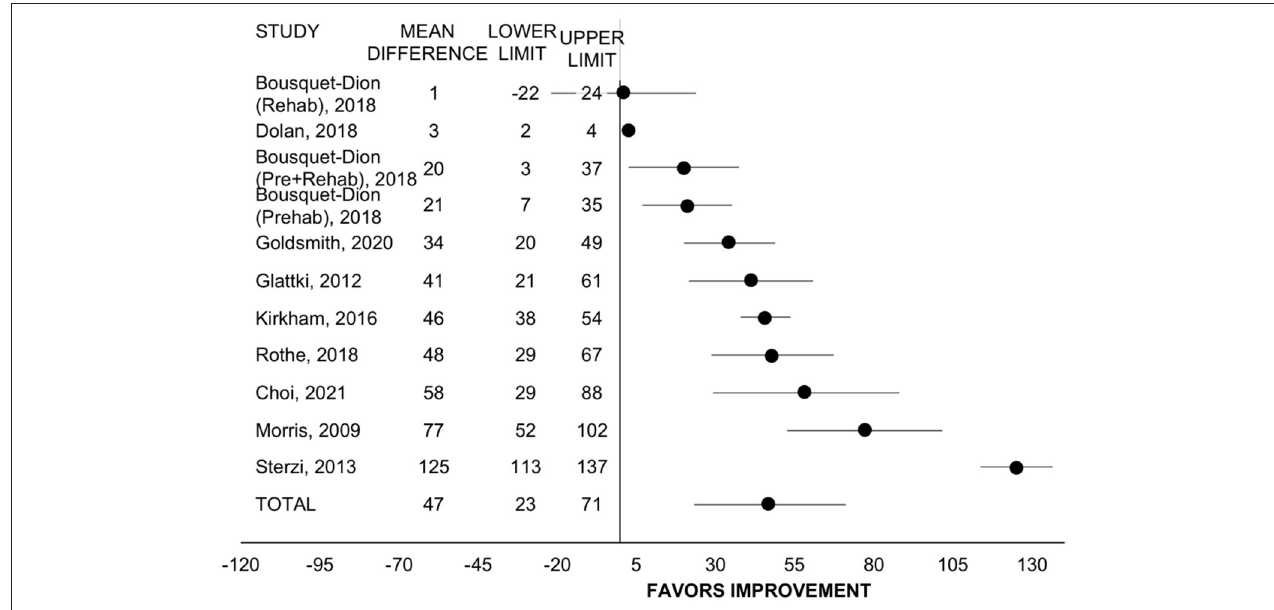
FIGURE 2 | Forest plot displaying mean difference and 95% CIs for the impact of pre/rehabilitation on 6-minute walk test distance (meters).